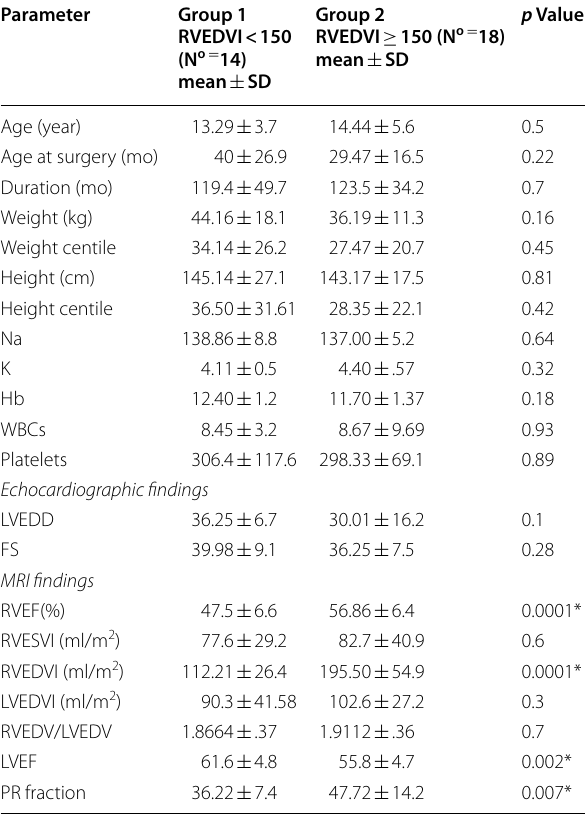
FS fractional shortening, LVEDD left ventricular end diastolic diameter, RVEF right ventricular ejection fraction, RVEDI right ventricular end diastolic volume index, LVEDV left ventricular end diastolic volume, LVEF left ventricular ejection fraction, PR fraction pulmonary regurgitation